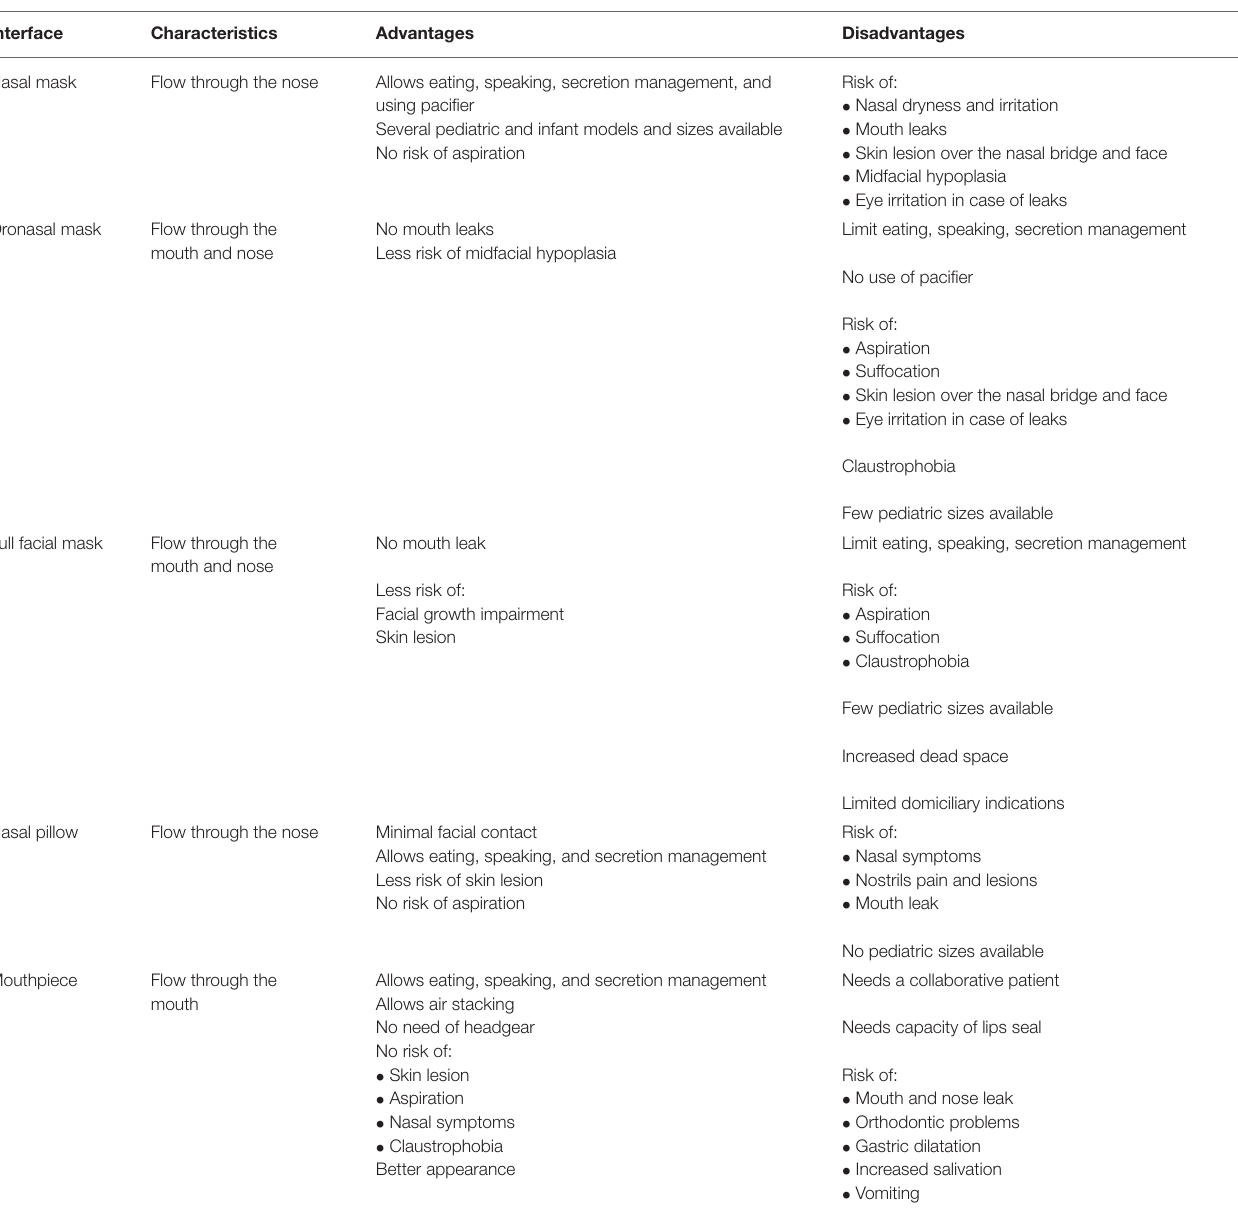
TABLE 1 | Advantages and disadvantages of interfaces.